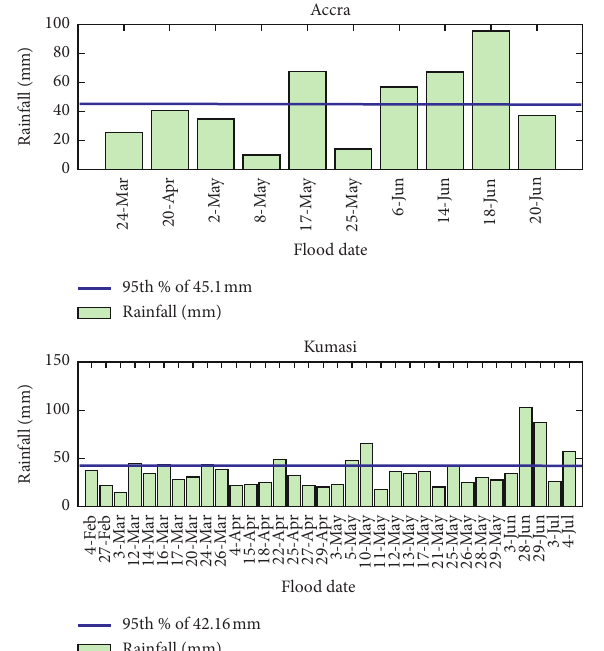
Figure 16: Accra and Kumasi 95th percentile threshold. This shows most flood events below the